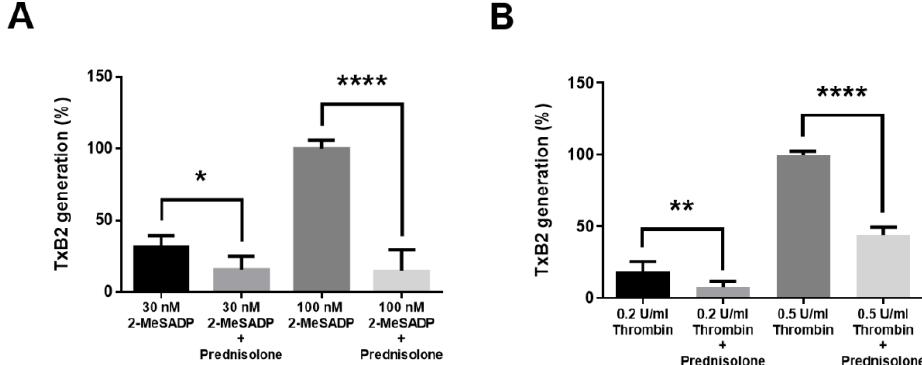
Figure 4. The effect of prednisolone on TxA 2 generation induced by 2-MeSADP and thrombin in platelets. Washed platelets were stimulated with different concentrations of ( A ) 2-MeSADP and ( B ) thrombin for 3.5 min in the presence or absence of 500 nM prednisolone and TxB 2 generation was measured ( n = 6). Data were expressed as percentages compared to 100 nM 2MeSADP and 0.5 U/mL thrombin groups and are shown as mean ± SE. *, p < 0.05; **, p < 0.01; ****, p < 0.0001.